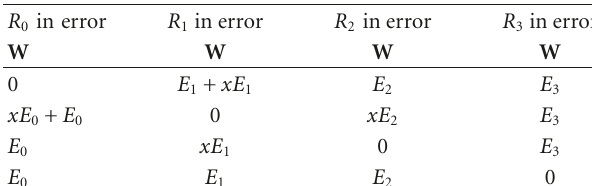
Table 2: The error locator matrix, W , for a single packet in error for the (4,2,3) systematic code.